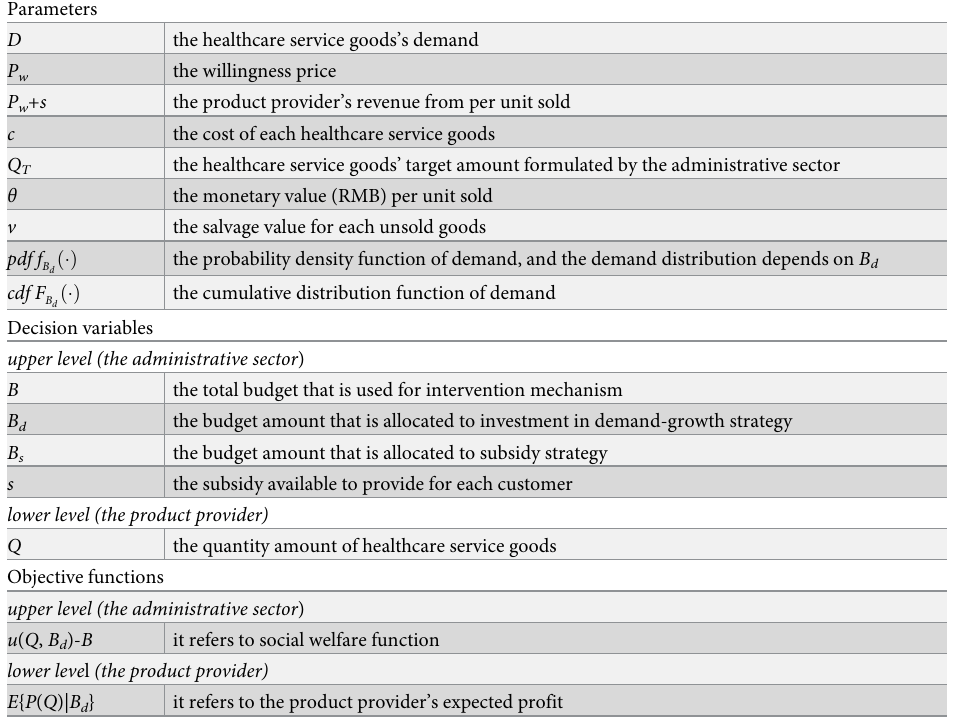
Table 2. Notations used in the bilevel programming